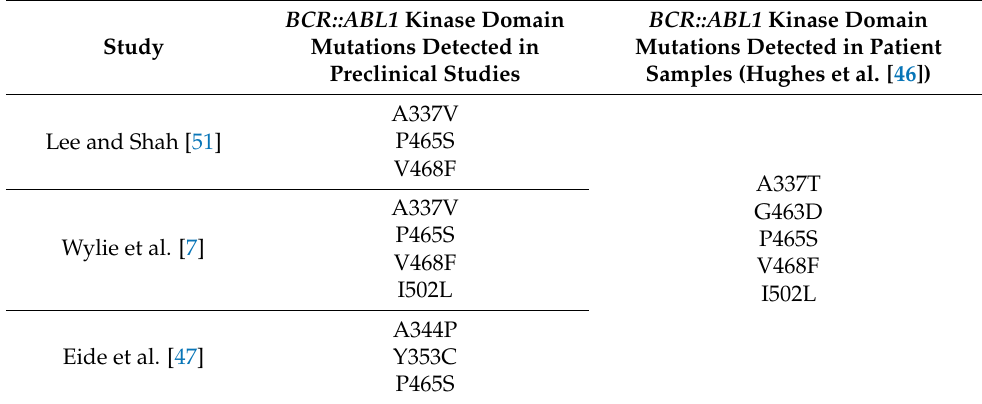
Table 1. BCR :: ABL1 kinase domain mutations, which include overlapping myristoyl-binding pocket mutations, that confer resistance to asciminib as predicted in preclinical studies and identified in patients treated with asciminib in a clinical